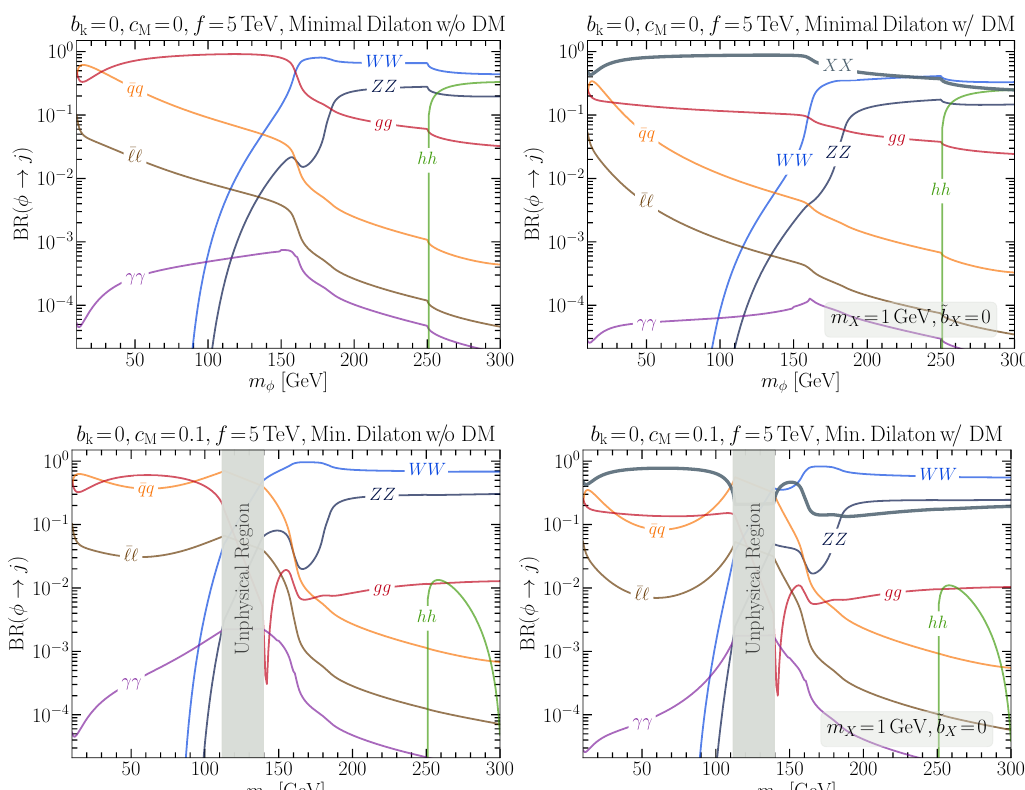
Figure 2 . Branching fractions of the dilaton in the minimal dilaton scenario as a function of dilaton mass m (cid:30) for di(cid:11)erent choices regarding the dark sector portal. The upper (lower) panel corresponds to the value of mass mixing parameter c = 0 (0 : 1). The gray band in the lower-panel m plots corresponds to the unphysical region where the correct Higgs and dilaton masses cannot be reproduced for the given dilaton-Higgs